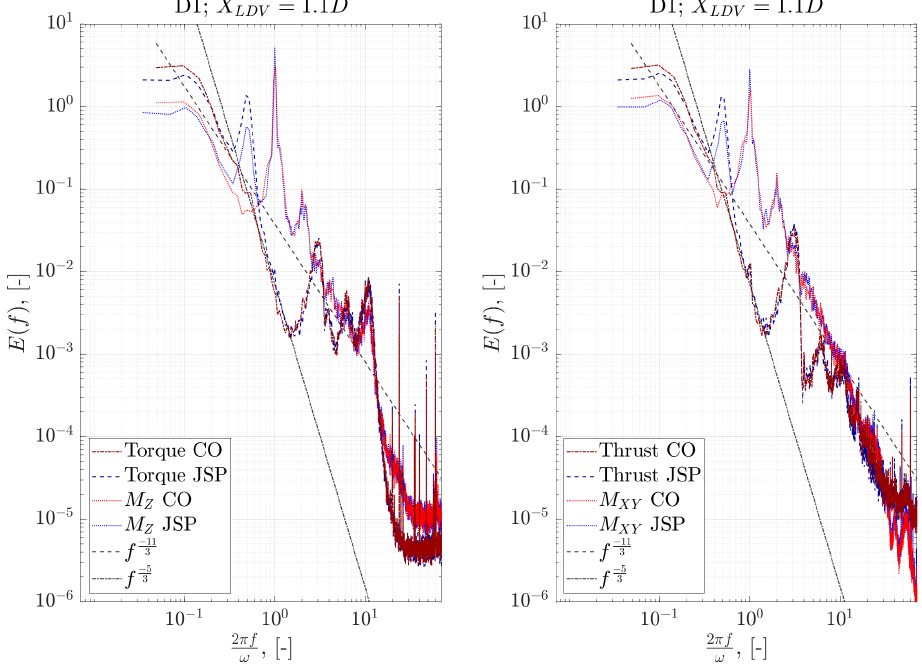
Figure 18. Mean power spectral density plots for torque-wise loading ( Left ) and thrust-wise loading ( right ) for all three datasets gathered at the D1 case for both CO and JSP